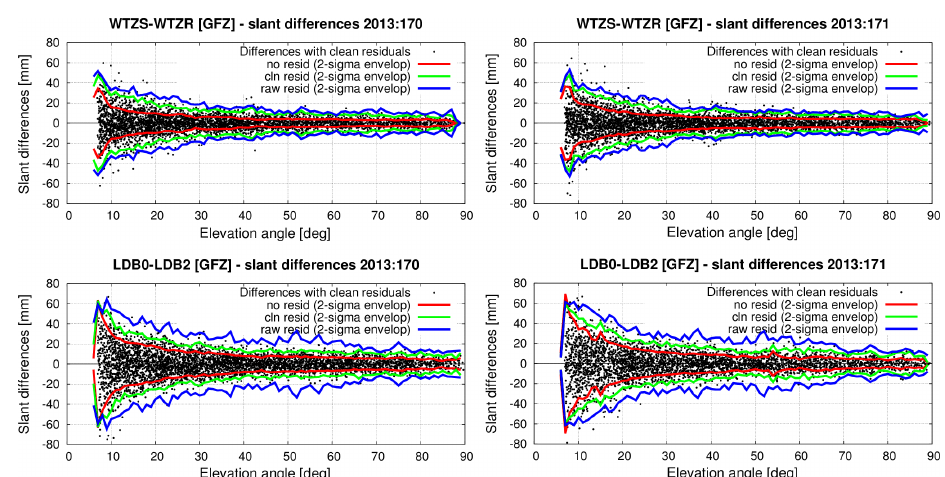
Figure 13. Elevation-dependent variability in STD differences of clean residuals (black dots) and their 2 σ envelopes (green curves) are showed for 19 June (DOY 171) and 20 June (DOY 170) and two dual-stations: WTZS–WTZR and LDB0–LDB2. Plots also display 2 σ envelopes for differences of raw residuals (blue curves) and without residuals (red